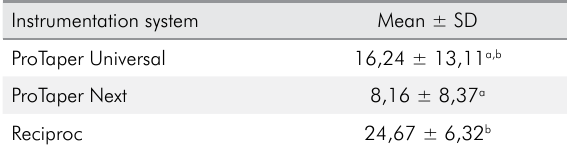
Table 2. Means and standard deviations of the volume (mm 3 ) of the sealer remaining in the root canal wall after different instrumentation